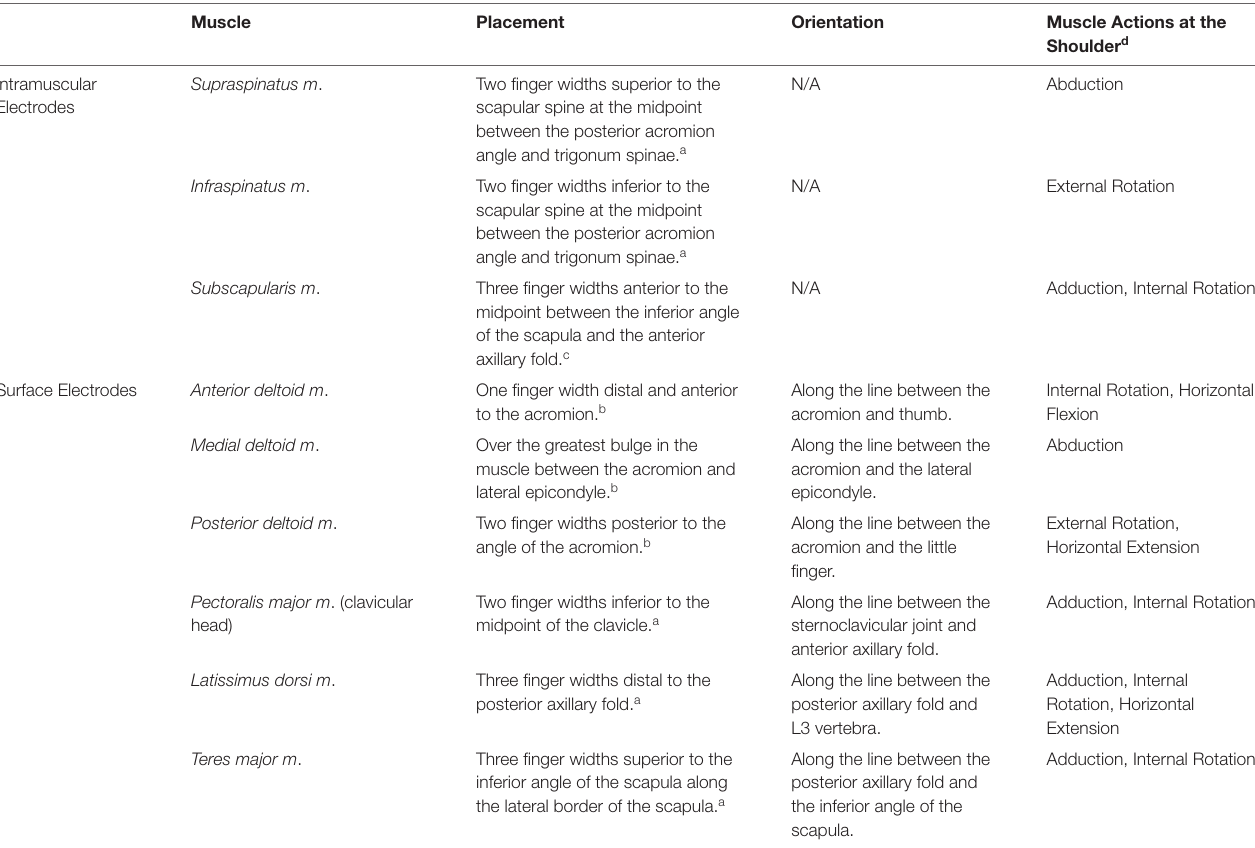
TABLE 1 | Muscles recorded by EMG and their corresponding electrode placements.